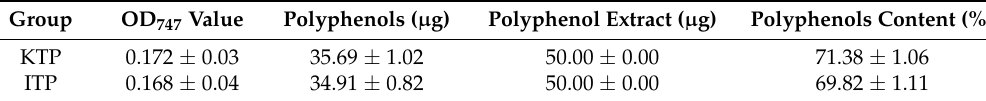
Figure 1. Standard curve of chlorogenic acid. Table 1. Polyphenol contents of KTP and ITP.